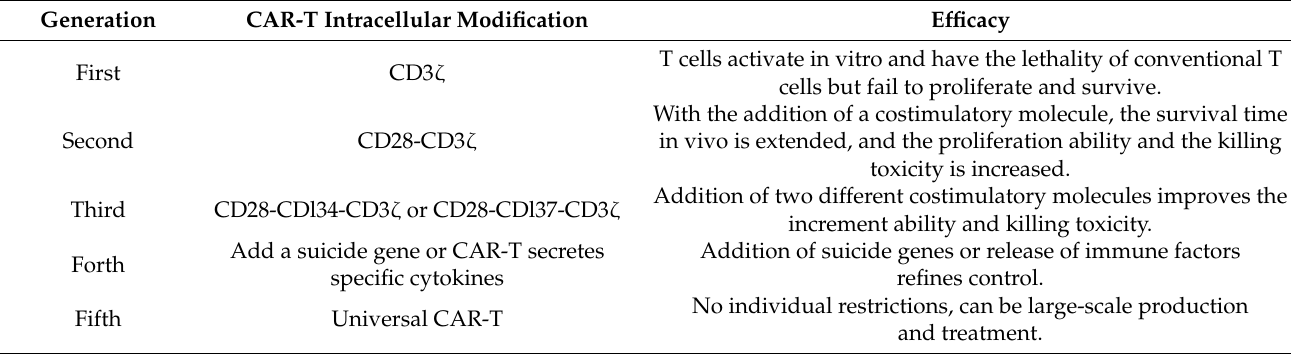
Table 1. Intracellular modification and function of